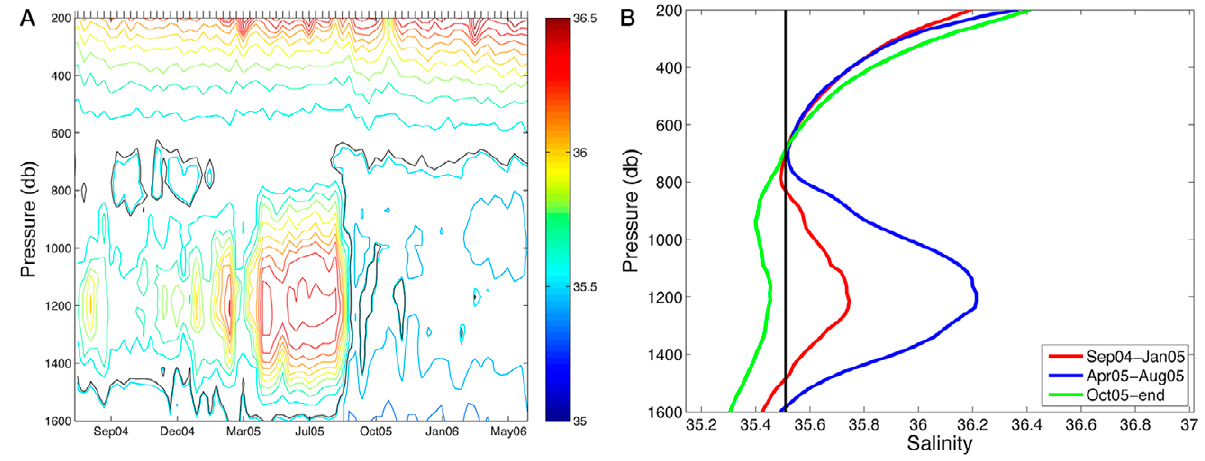
Fig. 5. – Salinities sampled by the float that tracked meddy F04. A, time-depth distribution. B, mean depth-salinity distributions grouped for three different periods as indicated; the vertical line corresponds to the salinity value of the deepest